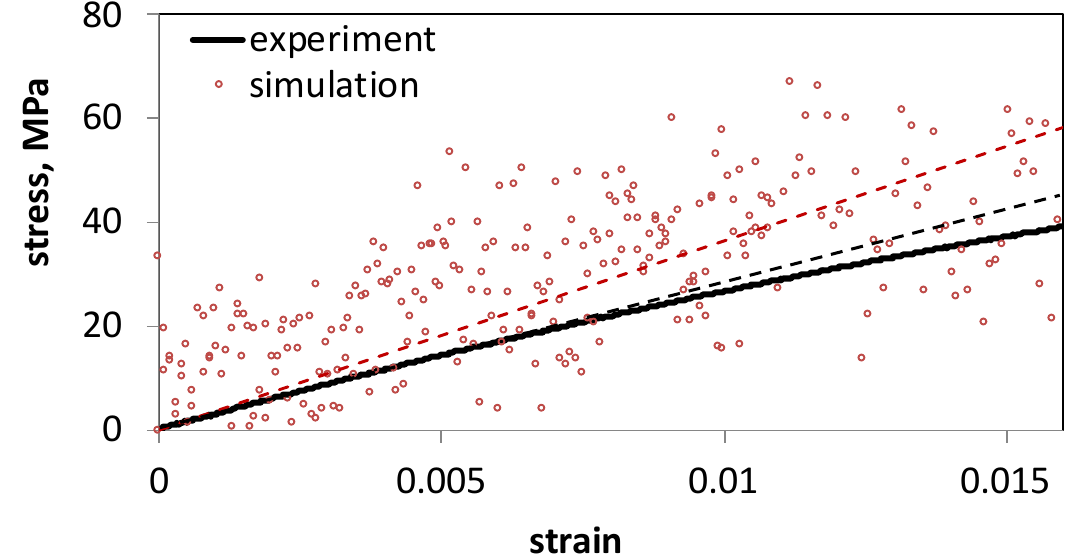
Figure 6. Stress versus strain for experimental measurements taken at room temperature and computational measurements at 25 °C and 90% cross-linking. Linear fits to the experimental data and simulation data are shown in black and red dashed lines, respectively.